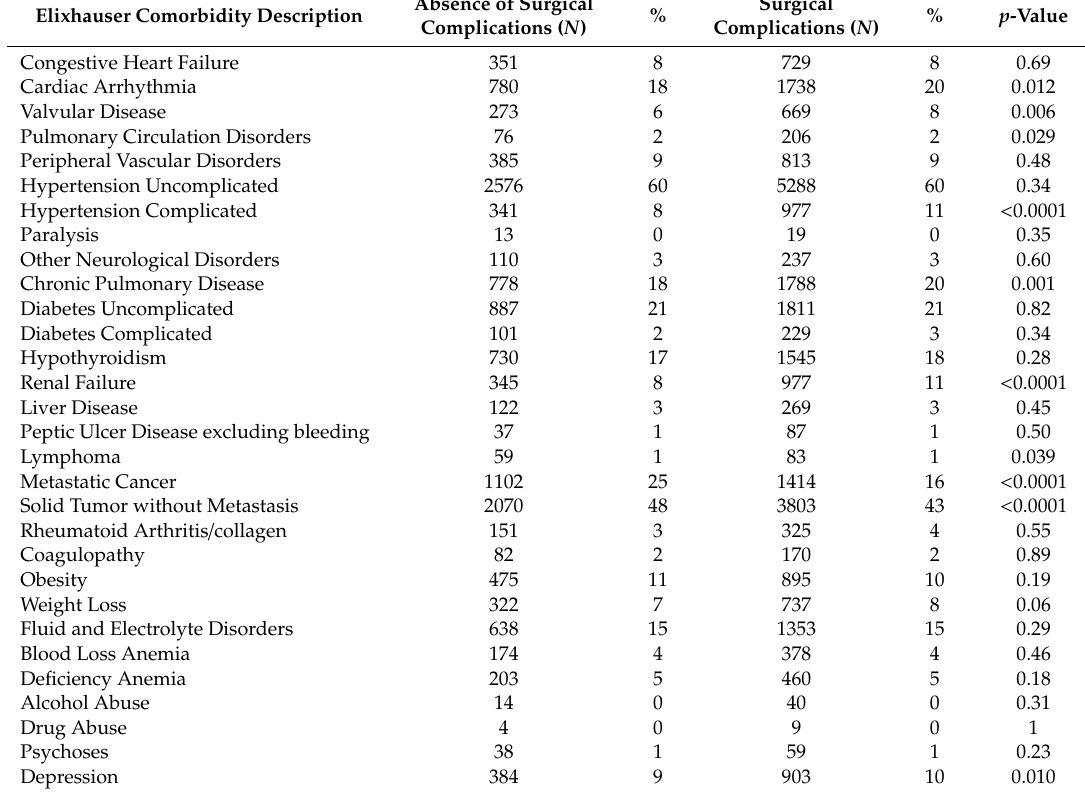
Table 2. Baseline on-admission comorbidity characteristics of